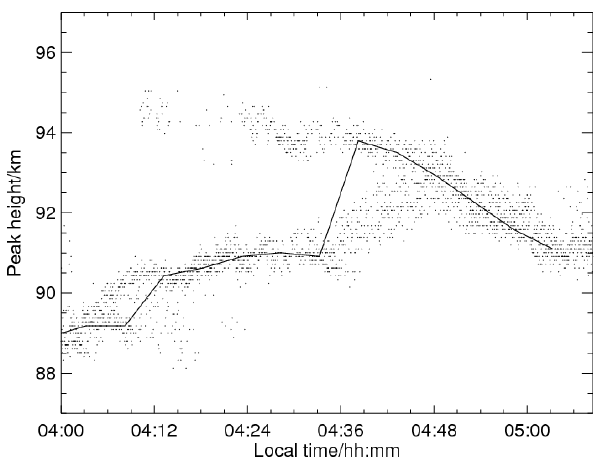
Fig. 6. Variations in the peak height of the Na s layer correspond- ing to Fig. 5 observed at different time resolutions. Dots show the 1.5s time resolution data, and the solid line represents the 5min